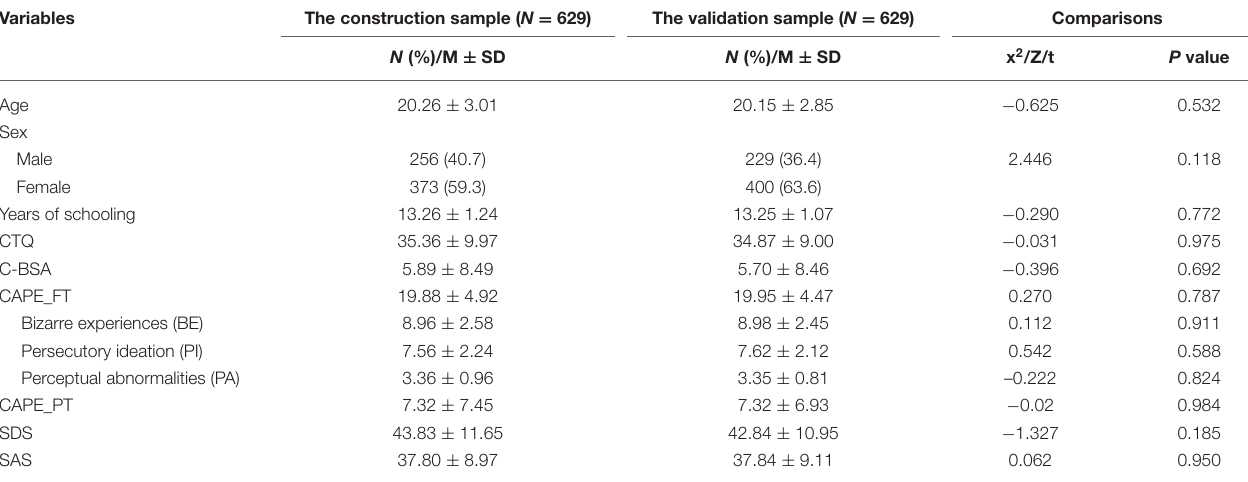
TABLE 1 | Demographic and clinical characteristics of the construction sample and the validation